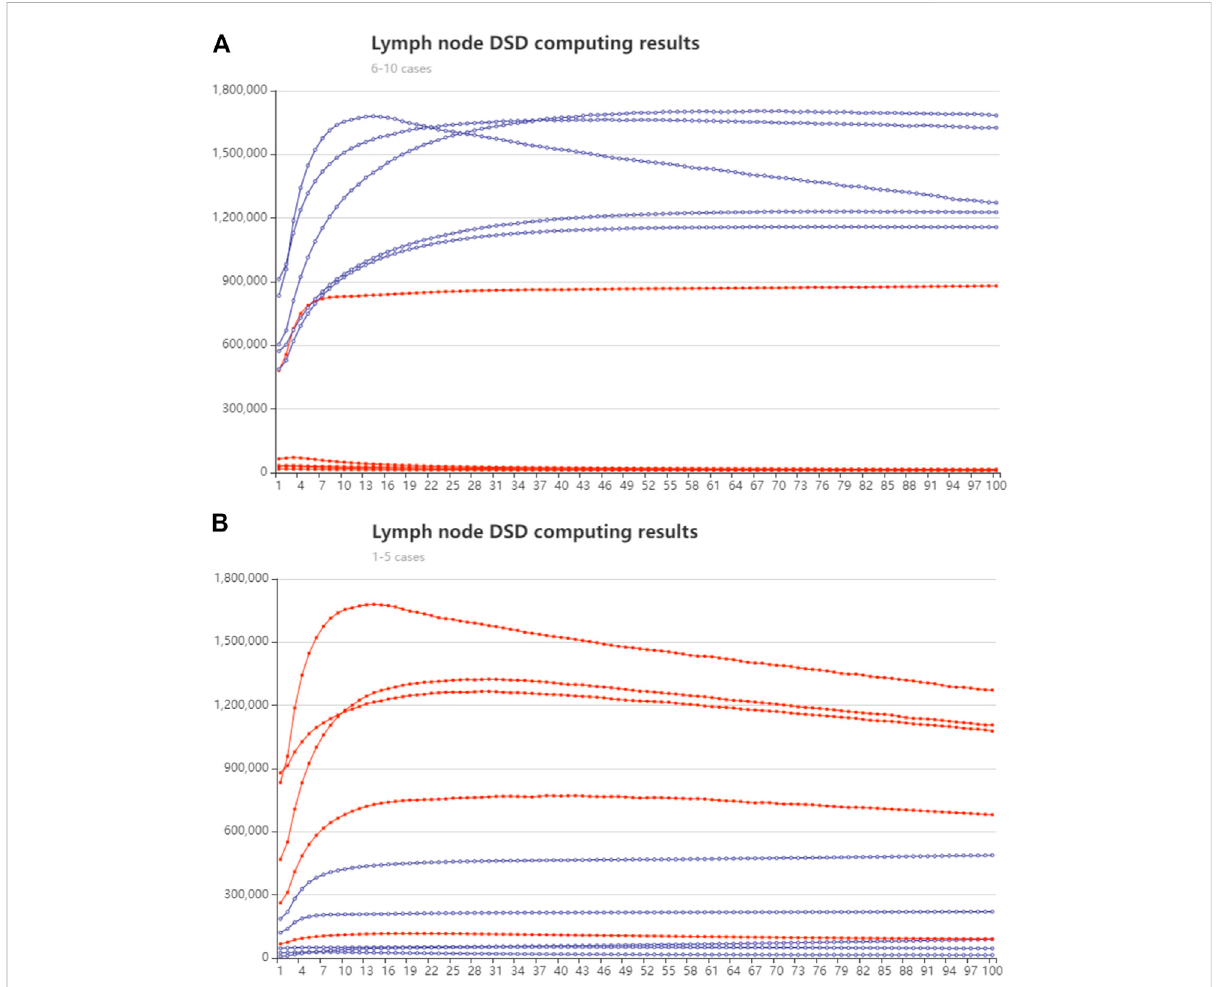
FIGURE 9 Lymph node number classi fi cation with DSD computed results. The red lines represent the trajectory of the ROX modi fi ed signal, and the blue lineisthetrajectoryofFAMsignal.The y -axisis fl uorescentintensity. X axisisthecyclenumber,10-spre-time (A) Groupone,lymphnodefewerthan 28, cases 6 – 10 Biomarker mir-99a predominates. (B) Group two, lymph node greater than 28, cases 1 – 5. Mir-451a